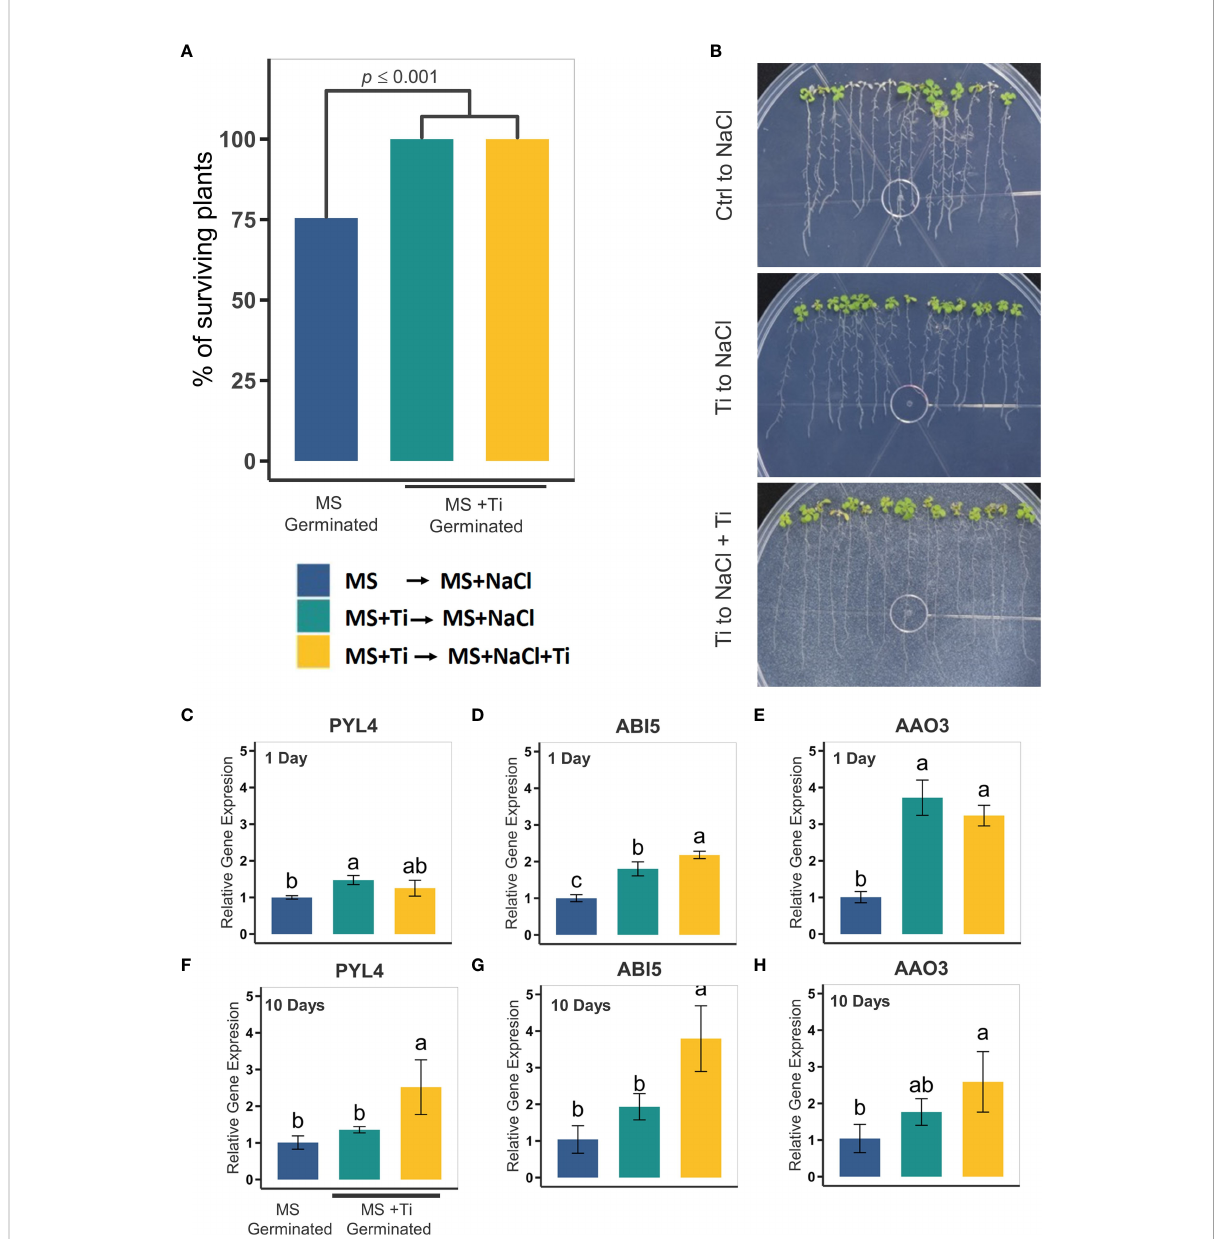
FIGURE 7 Effect of Titanium (Ti) on Arabidopsis tolerance to high salinity. (A) Percentage of surviving plants seven days after exposure to 80 mM NaCl. Plants were germinated in MS and then transferred to MS containing 80 mM NaCl (blue bars). Plants treated with Ti were germinated in MS medium containing 2 mM Ti and then transferred to MS media with 80 mM NaCl (green bars) or MS media containing 80 mM NaCl and 2 mM Ti (yellow bars). (B) Representative photographs of plants under each treatment seven days after salt-stress exposure. Relative expression of salt- stress related genes in Arabidopsis in roots: PYL4 (C) , ABI5 (D) , AAO3 (E) one day after Ti treatment; and PYL4 (F) , ABI5 (G) , and AAO3 (H) . Different letters indicate statistically signi fi cant differences according to Tukey ’ s signi fi cance test ( p <